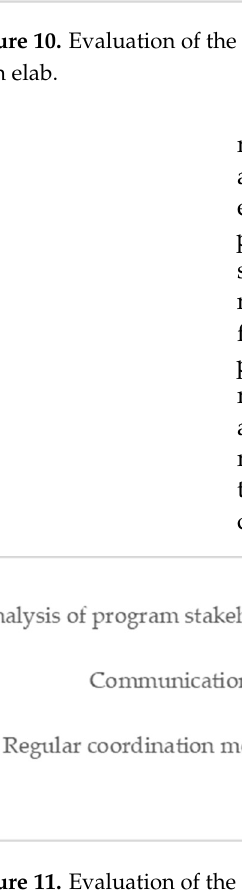
Figure 11. Evaluation of the effectiveness of the methods, techniques and tools used for the communication control process. Source: own elab.